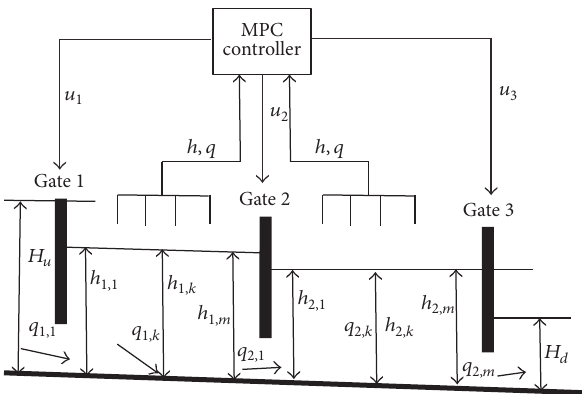
Figure 3: Structure of predictive control scheme.